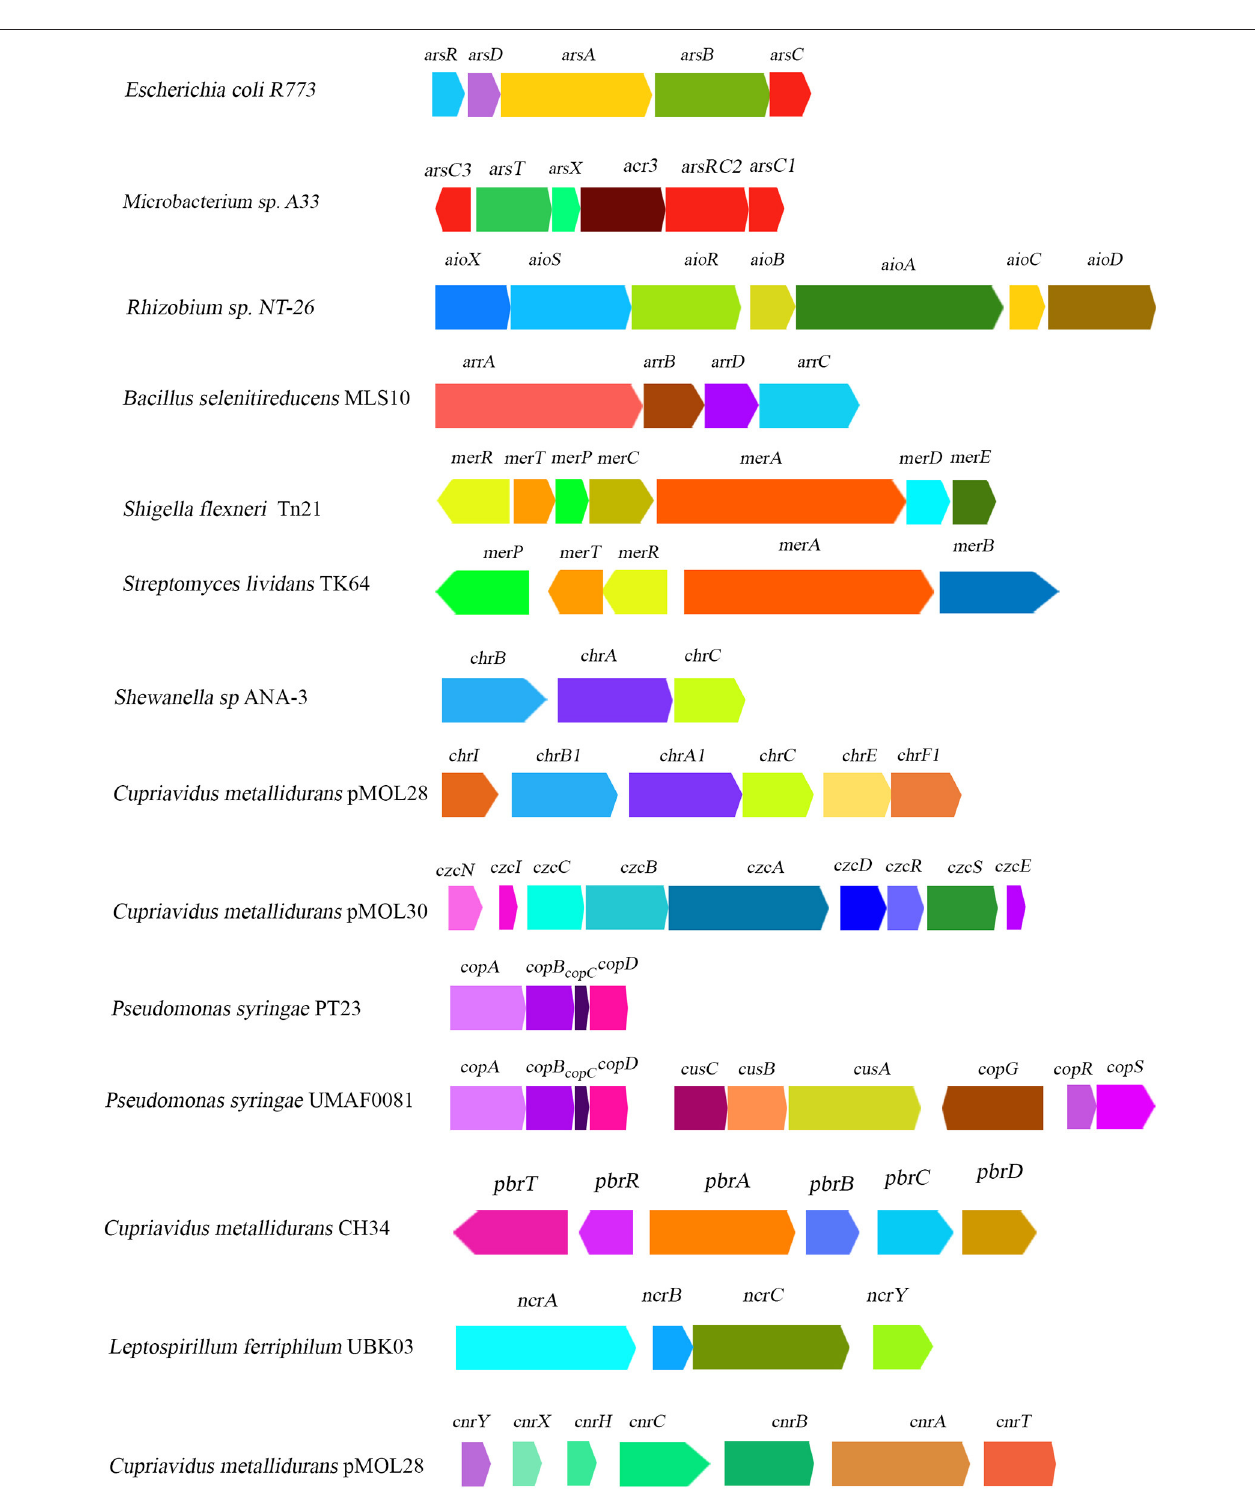
FIGURE 2 | Schematic diagram illustrating the organization of heavy-metal-resistant related gene clusters reported from some major representative bacterial genera.